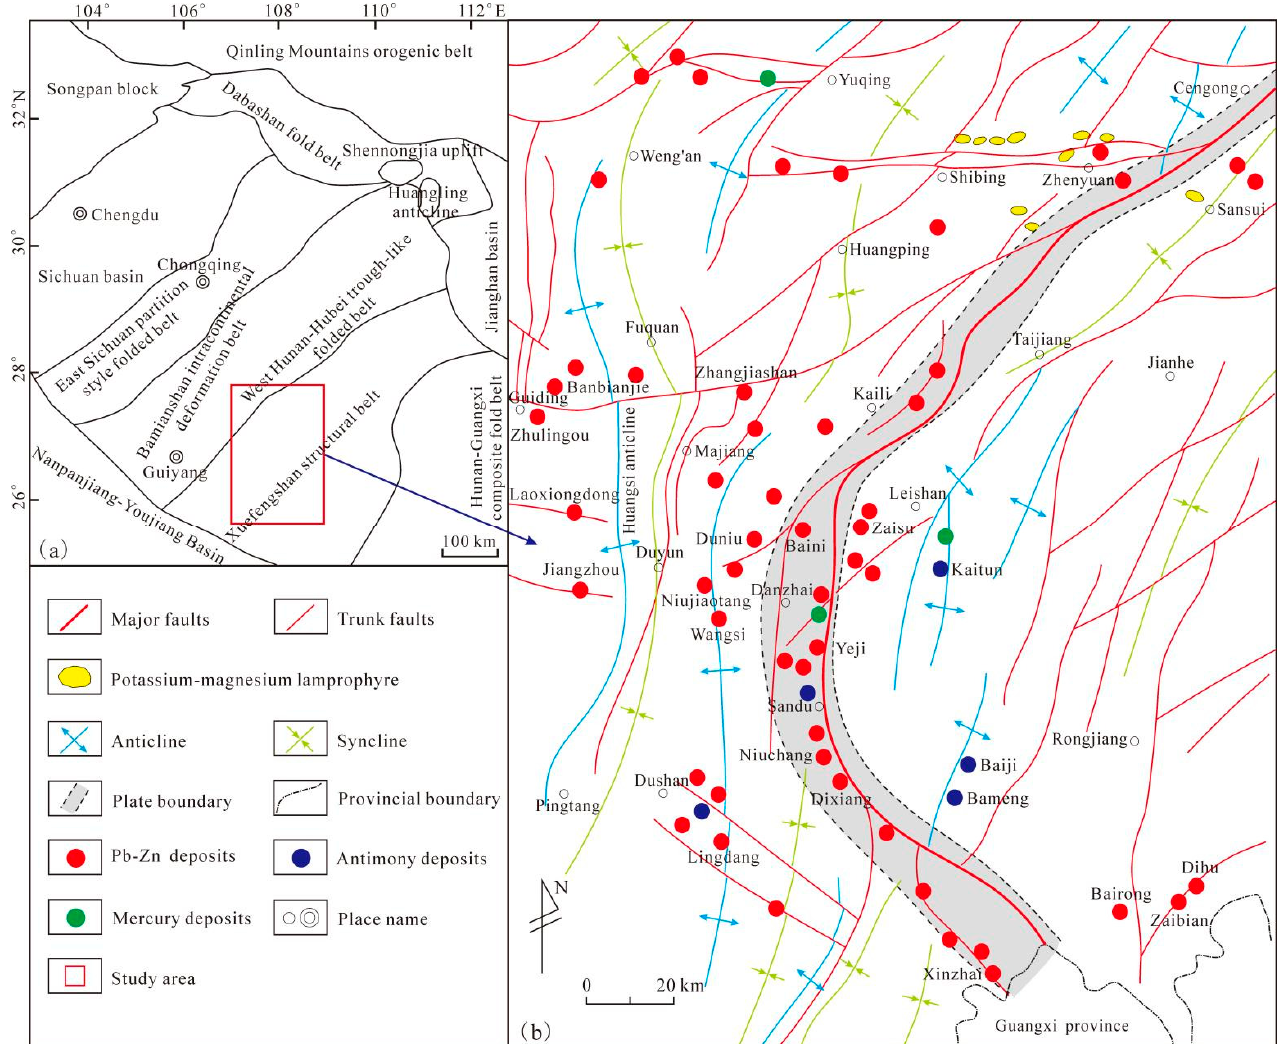
Figure 1. Geotectonic position of the study area: ( a ) according to Ref. [3] and fault structures, deposits distribution map ( b ): according to Ref. [26].